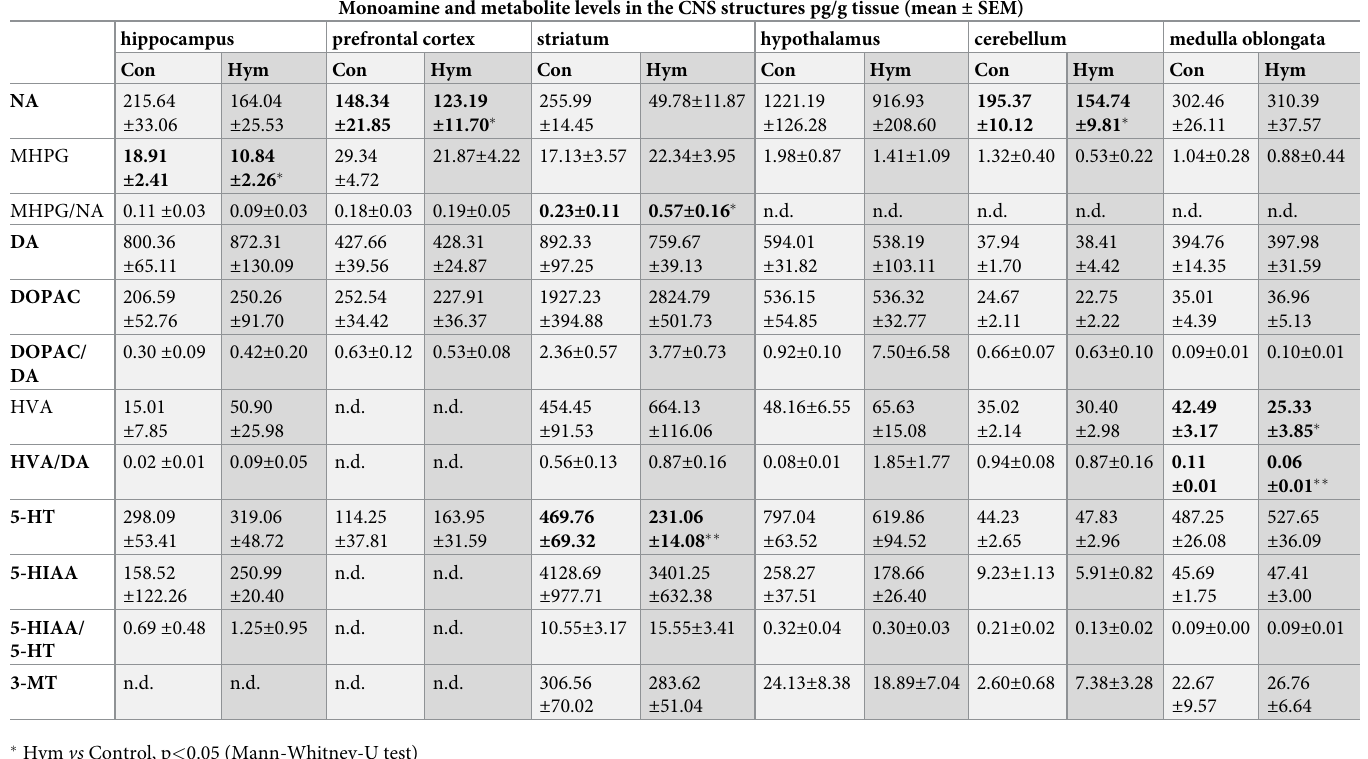
Table 1. Monoamine and metabolite levels in the CNS structures of control rats (Con, n = 8) and rats infected with H . diminuta (Hym, n = 7) determined by high- performance liquid chromatography. Monoamine and metabolite levels in the CNS structures pg/g tissue (mean ±